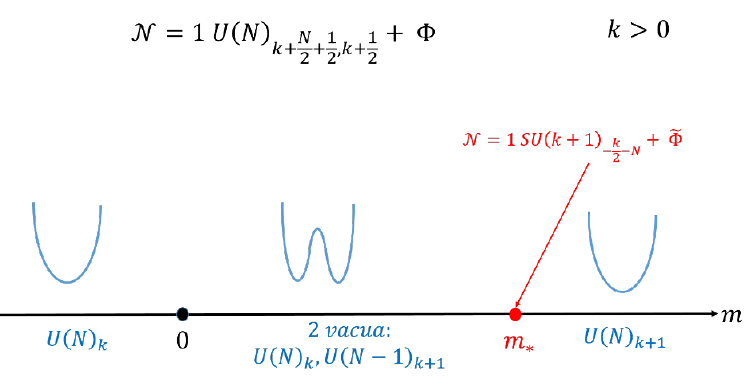
gauge theory coupled to a single funda- k + N +1 ;k + 1 2 2